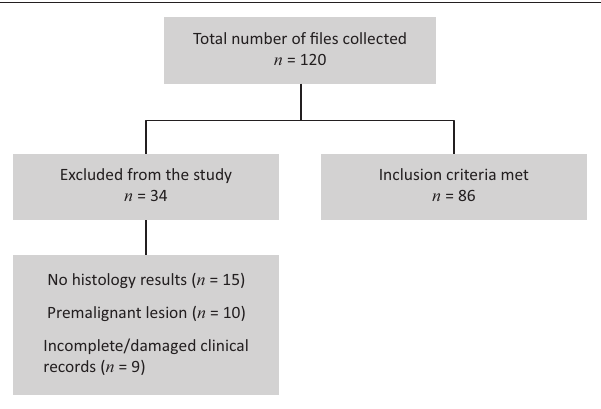
FIGURE 1: Flow diagram of the study population.